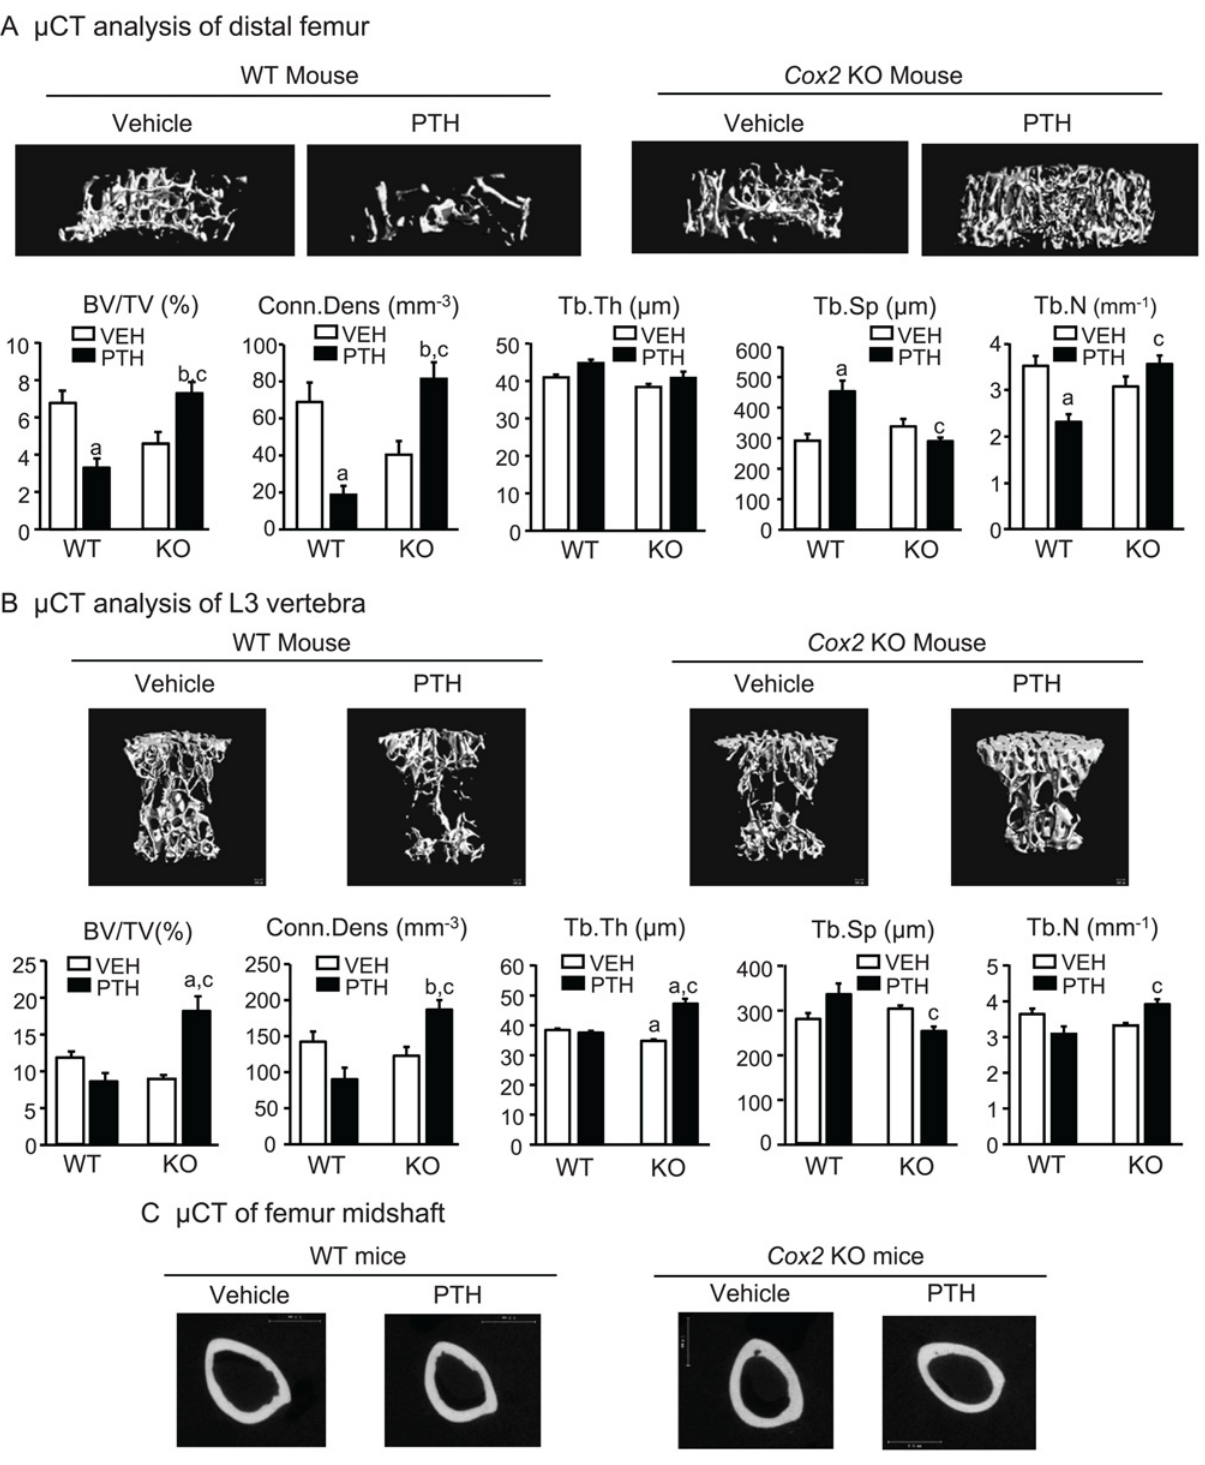
Fig 6. Morphometry of femoral trabecular bone and L3 vertebrae in mice infused for 21 days. A. Representative μ CT images (top panel) and morphometric analyses (bottom panel) of trabecular bone in the metaphyseal region of distal femur. B. Representative μ CT images (top panel) and morphometric analyses (bottom panel) of trabecular bone in L3 vertebrae. Bars are means ± SEM for 6 WT and 6 KO mice infused with vehicle and 7 WT and 7 KO mice infused with PTH. a Significant effect of PTH, p < 0.01; b p < 0.05. c Significant effect of genotype, p < 0.01. C . Representative μ CT cross-sectional images of midshaft of